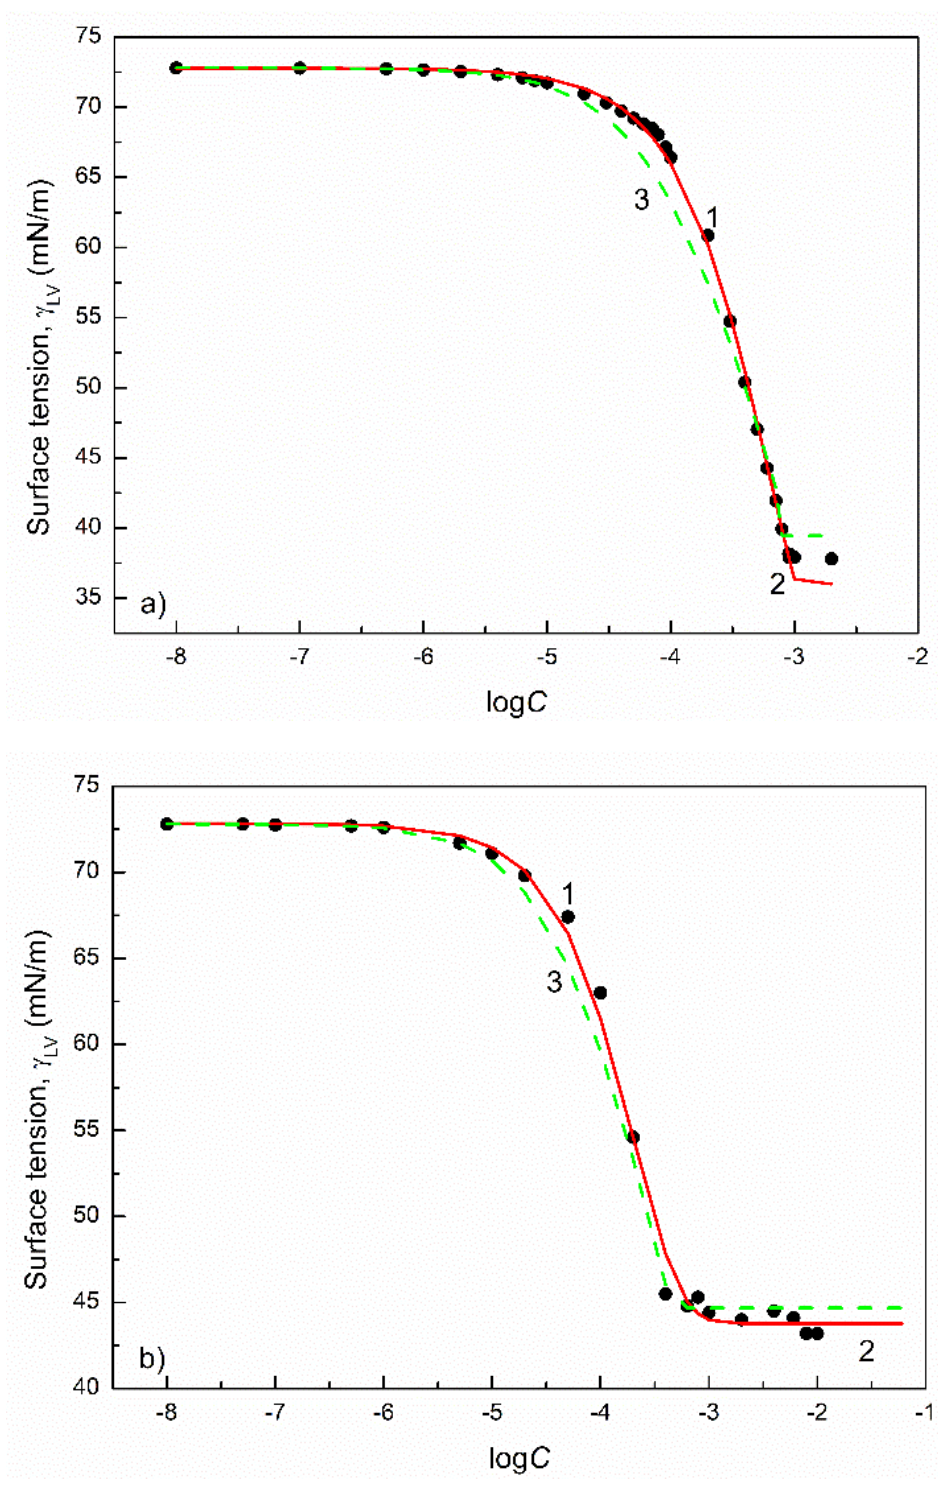
Figure 1. A plot of the surface tension ( 𝛾 𝐿𝑉 ) of the aqueous solutions of CTAB ( a ) and CPyB ( b ) vs. the logarithm of their concentration ( 𝑙𝑜𝑔𝐶 ). Points 1 correspond to the measured values [32], curves 2 and 3 correspond to the values calculated from the exponential function of the second order (Equation (2)) and Szyszkowski equation (Equation (3)), respectively.